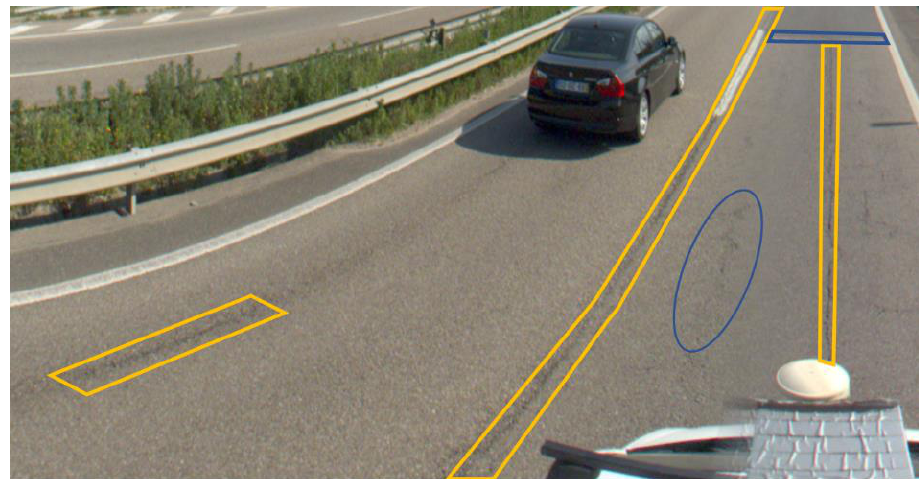
Figure 9. Road spot 1. Ladybug camera image with delimited cracked areas.